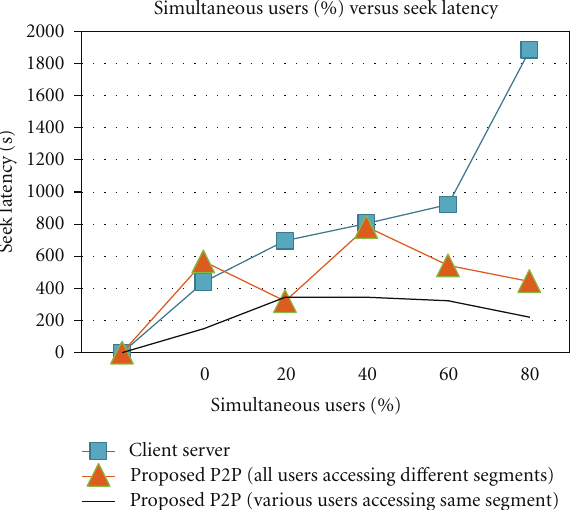
Figure 7: % of simultaneous users versus seek latency.